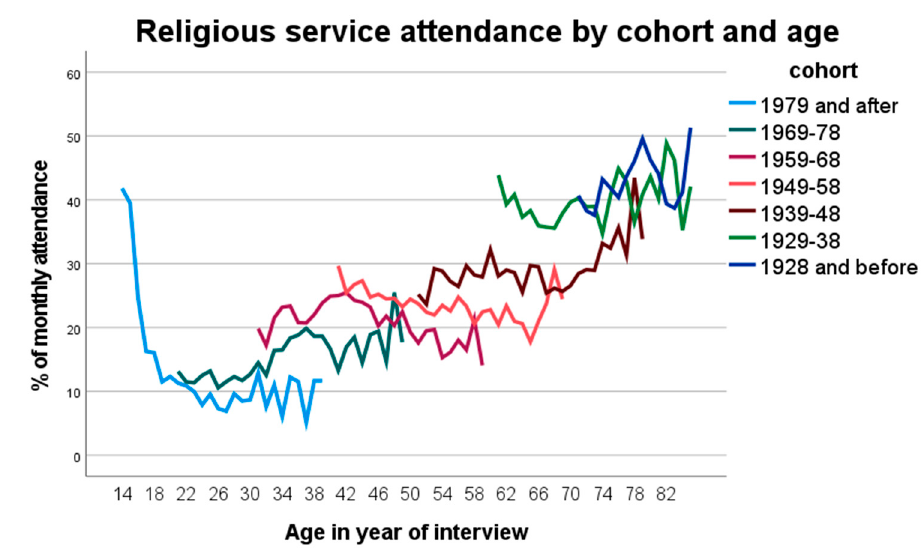
Figure 4. Proportion of participants in religious services by cohort and age.